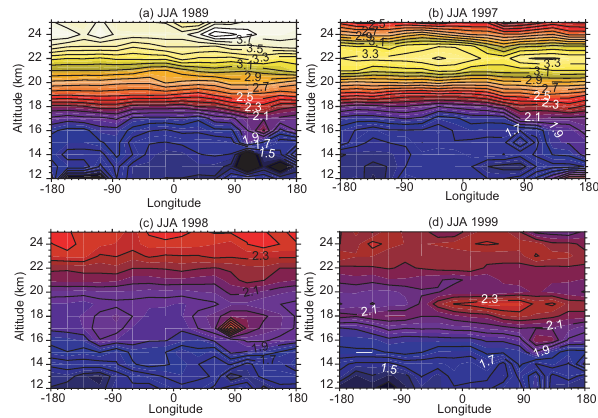
Fig. 10. JJA depictions of median aerosol extinction coefficient ratio (relative to molecular) for SAGE II observations between 15 and 45 ◦ N for individual years: 1989 (a) , 1997 (b) , 1998 (c) , and 1999 (d) . Contours are drawn every 0.1 from 1.4 to 4.0.